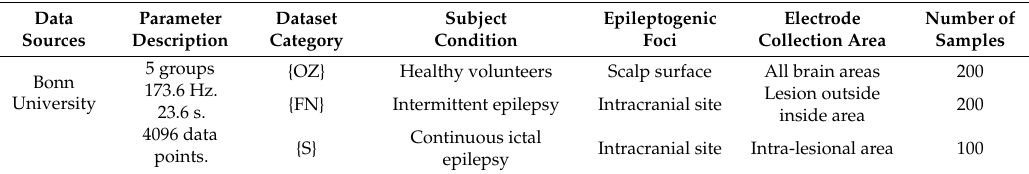
Table 1. Dataset